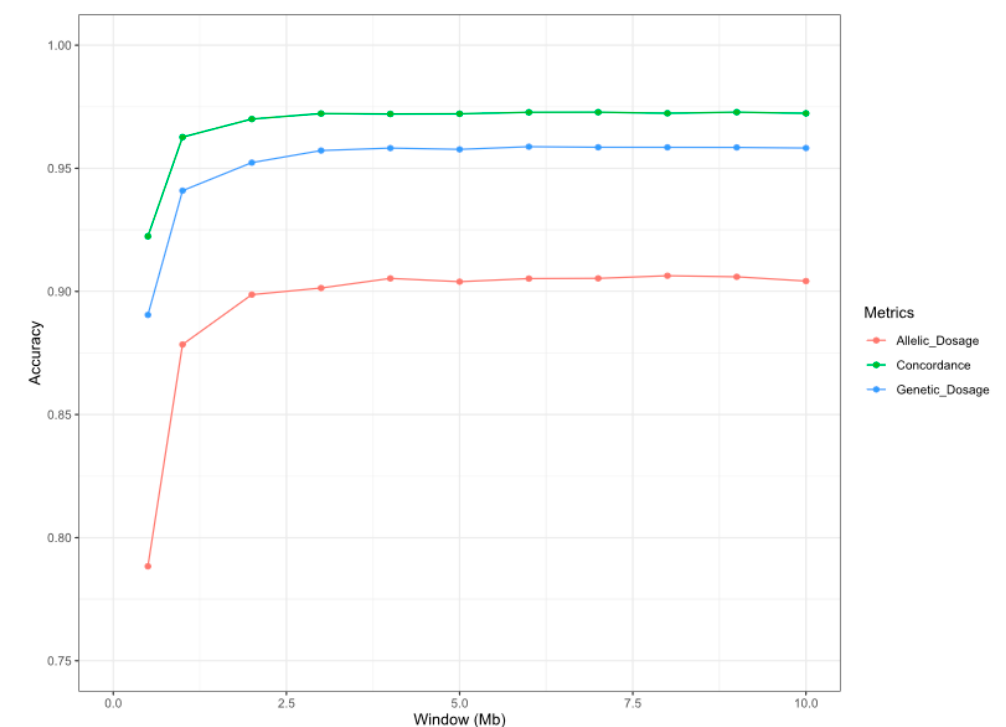
Figure 1. Graphical representation of the accuracy of the microsatellite imputation considering different window lengths in the imputation process. The x -axis represents the window sizes (in bp) considered in the imputation process. The y -axis represents the average of the imputation accuracy parameters (concordance (green), genotype dosage (blue), and allelic dosage (orange)) of the 19 microsatellites included in this study.